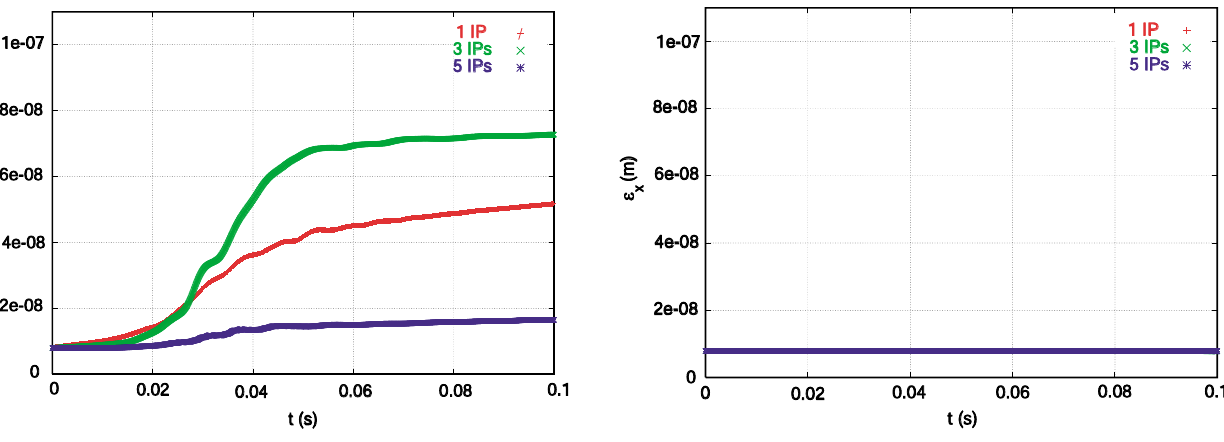
FIG. 79. (Color) Simulated evolution of LHC emittance versus (cid:3) 6 (cid:1) 10 11 m (cid:2) 3 when the bunch centroid time in seconds for (cid:31) e motion is suppressed at each IP; the curves correspond to differ- ent numbers of electron-beam IPs